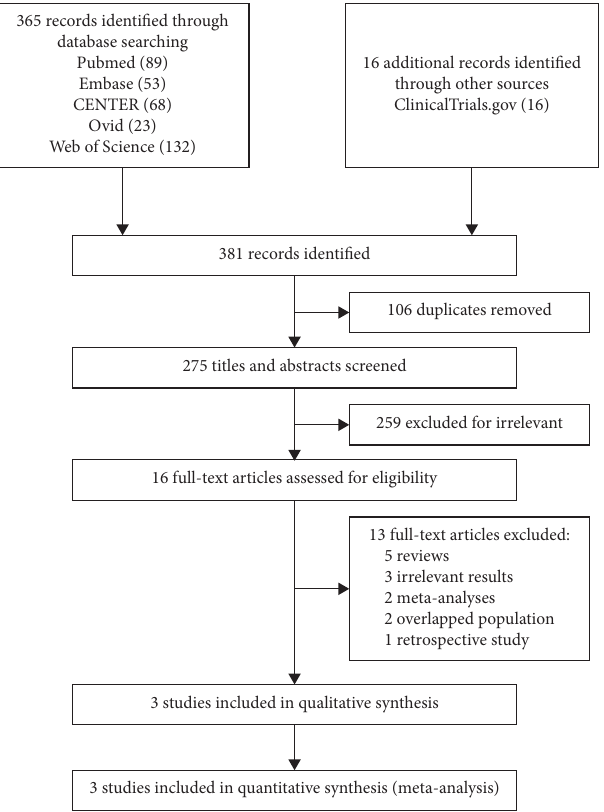
Figure 1: Flow diagram of study